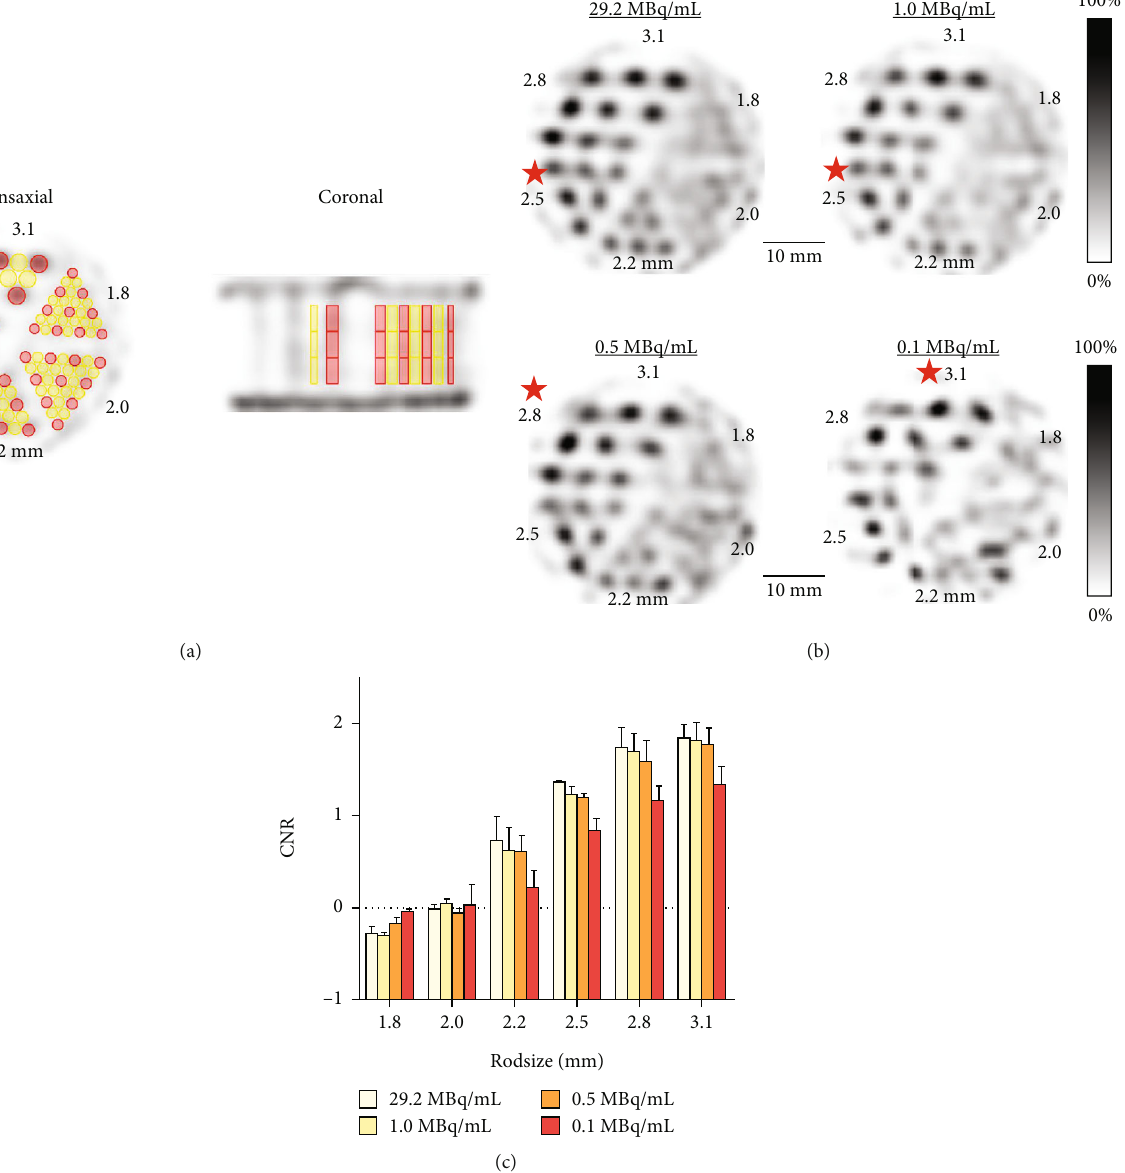
Figure 2: Resolution and contrast-to-noise ratios of the hot-rod phantom images. (a) Representative transaxial and coronal SPECT images of the phantom. Red and yellow cylinders indicate VOIs for hot and cold areas, respectively. (b) SPECT images of the hot-rod phantom containing 4 di ff erent activity concentrations. Slice thickness of 5.0 mm and Gaussian post fi lter of full width at half maximum (FWHM) equal to minimum rod size of 1.8mm were applied. Star marks represent the smallest rod size that can be clearly distinguished on the images of each activity concentration. (c) Contrast-to-noise ratios for the di ff erent activity concentrations. Analyzed images were optimized for each rod size by a Gaussian post fi lter of FWHM equal to each diameter of the corresponding